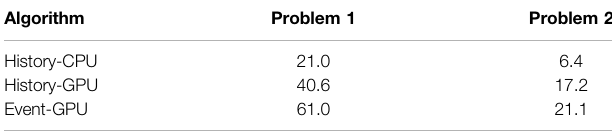
TABLE 7| Trackingrate ( 10 4 n / s ) forproblem1andproblem2inthecontinuous- energy Quicksilver